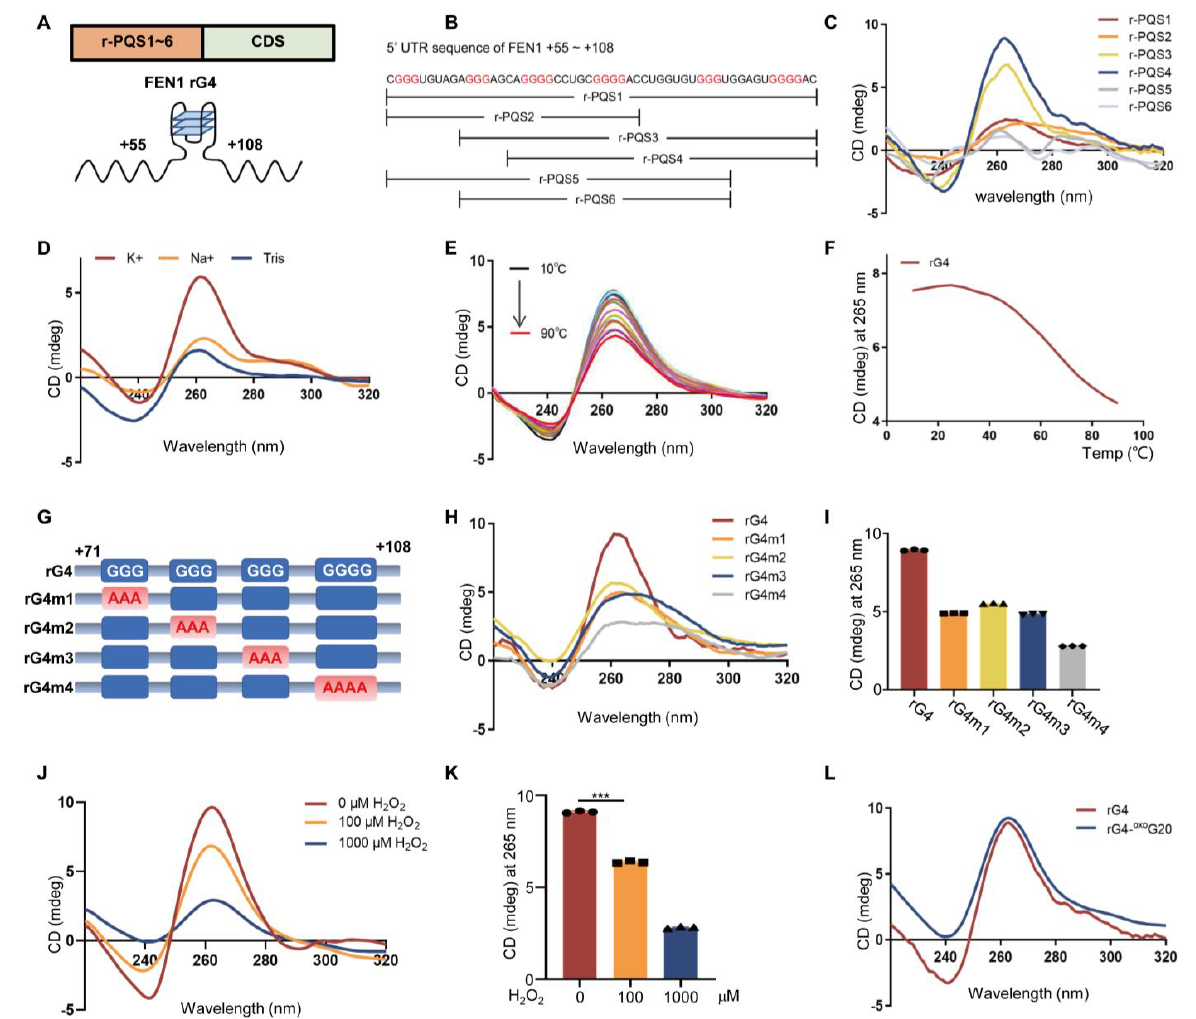
Figure 2. A G − quadruplex structure exists in the 5′ UTR region of FEN1 mRNA. ( A ) Description of the G4 position in FEN1 mRNA. ( B ) There are six G4 − forming sequences (r − PQS1~6) in the 5′ UTR region of FEN1 mRNA. ( C ) A total of 5 M PQS was folded into the G4 structure in G4 buffer and then detected by CD respectively. ( D ) Effect of metal ions on the CD spectra of G − quadruplexes. The effect of KCl (red line) and NaCl (orange line) on the ellipticity signal compared to the signal without salt. All CD data were obtained at 25 °C with an oligonucleotide concentration of 5 M. ( E ) The effect of temperature (10~90 °C) on the CD spectrum of FEN1 rG4. At 90 °C, rG4 still produced a strong CD spectral signal of the G − quadruplex. ( F ) Temperature dependence of FEN1 rG4 ellipticity at 265 nm. ( G ) The effect of different G − tracks on rG4 formation. We replaced guanine (G) with adenine (A) in each G − track, and obtained 4 mutants, labeled as rG4m1~4. ( H ) The oligonucleotides containing wild type or mutations of rG4 (rG4m1~4); the samples (5 M) were used for CD spectra. ( I ) Molar ellipticity at 265 nm of individual mutants. ( J ) CD spectra for FEN1 5′ UTR RNA oligonucleotides, which were folded in G4 buffer to form an rG4 structure, with or without different concentrations of H 2 O 2 . ( K ) Statistical analysis of ellipticity at 265 nm for each sample. ( L ) The key site of the FEN1 rG4 − forming sequence was labeled with an 8 − oxoG and detected by CD after annealing. Data shown are the mean ± SD from three independent experiments. *** p < 0.001 as determined by the Student ’ s t − test.